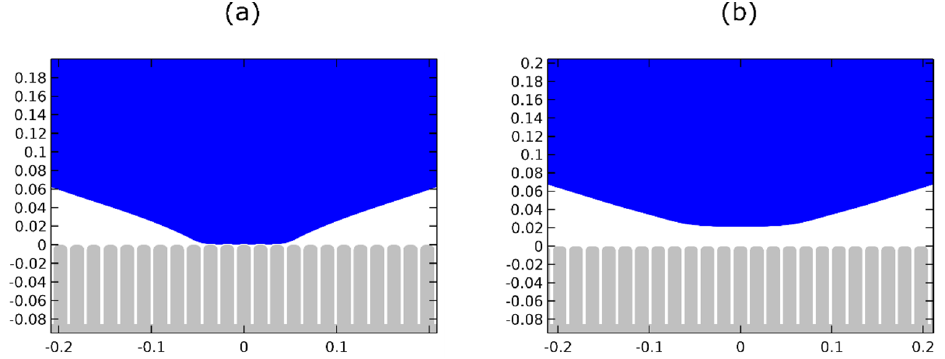
Figure 7. Magnification of the droplet ( a ) before and ( b ) after detachment from the micro-structured surface (stripes I), ( h = 85 µ m, w = 15 µ m, d = 3 µ m and r = 5 µ m )